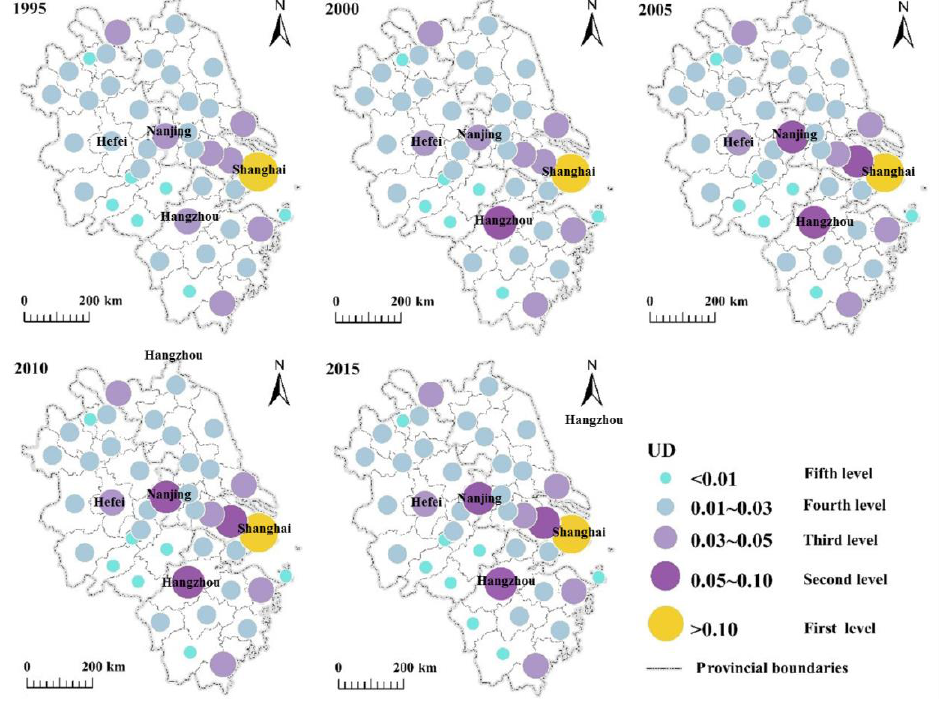
Figure 3. City-level structural maps of the YRD region.